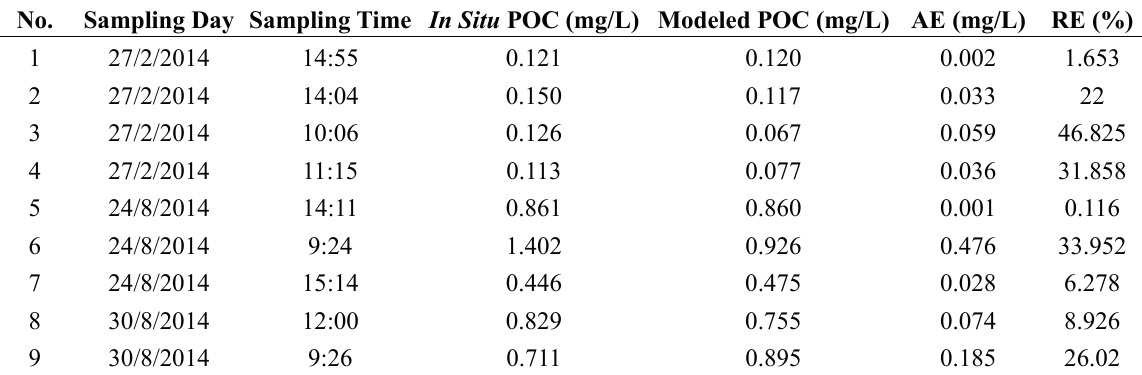
Table 1. Comparison results between in situ and modeled POC concentrations using the algorithm developed in this study. AE and RE are defined in Equation (4). Sampling time is the local time when MODIS/AQUA was